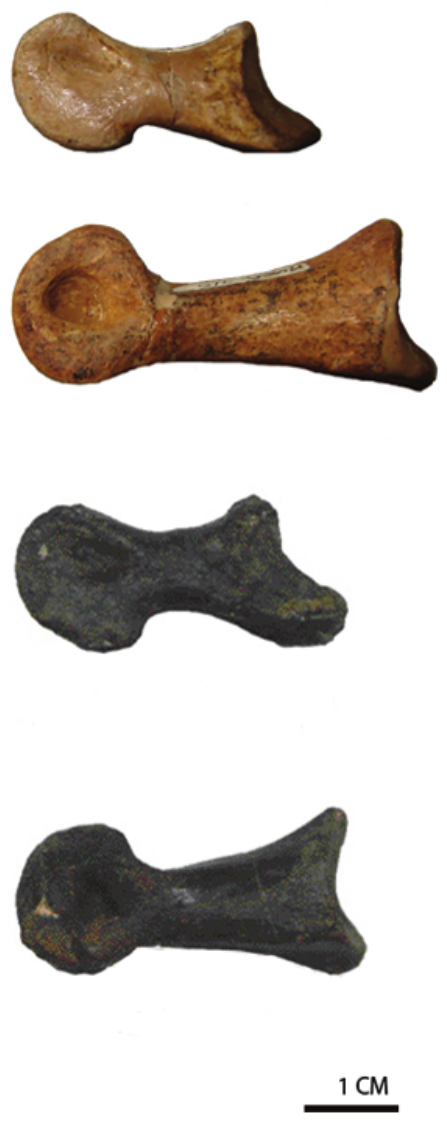
Fig. 7 – Phalanges of digit II of Unenlagia paynemili and Neuquen- raptor argentinus in lateral